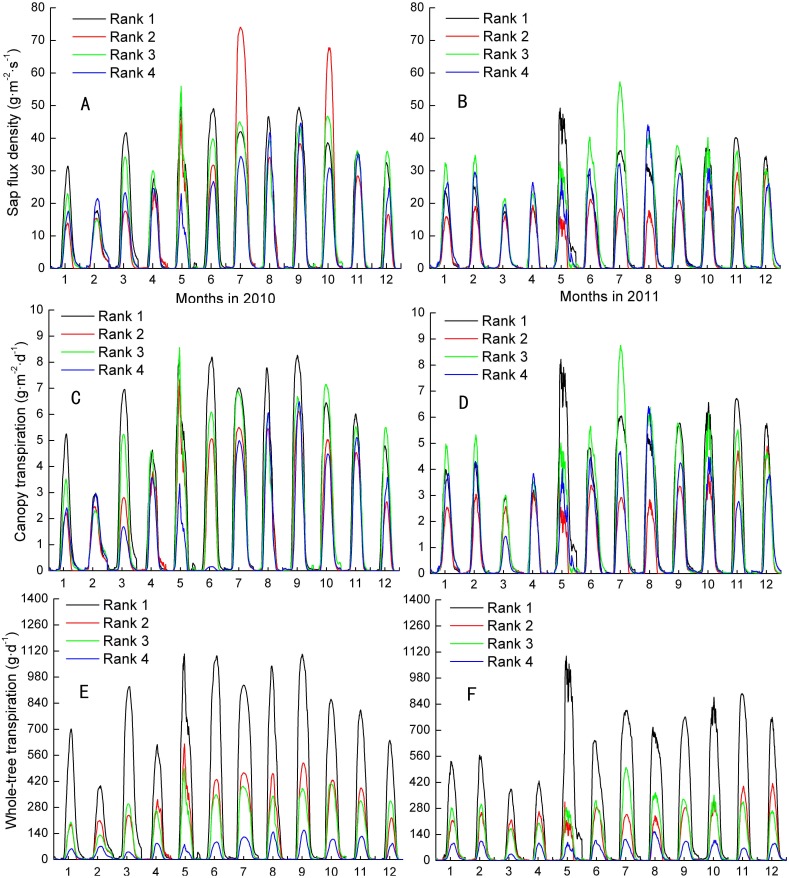
Inter-classes comparison in sap flux density, canopy transpiration and whole-tree transpiraiton.Rank 1 represented trees at DBH > 0.20 m; Rank 2 was trees at 0.15 m< DBH ≤ 0.20 m; Rank 3 was trees at 0.10 m< DBH ≤ 0.15 m; Rank 4 represented trees at 0.05 m< DBH≤ 0.10 m.